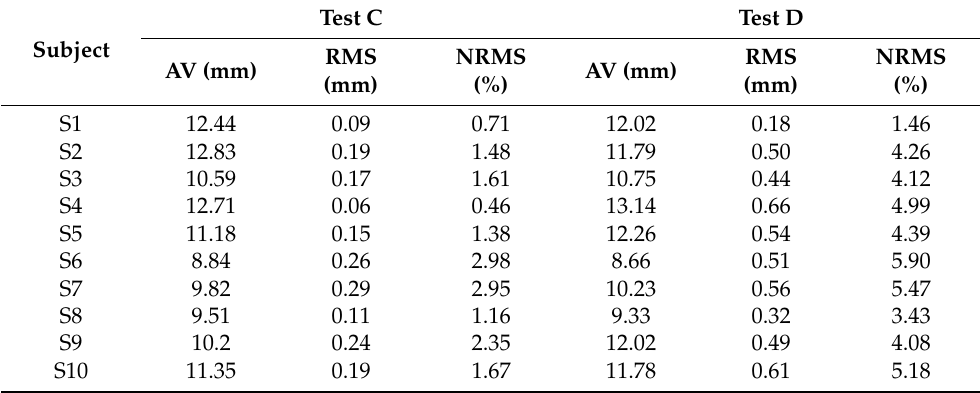
Table 1. Results of Test C and Test D.